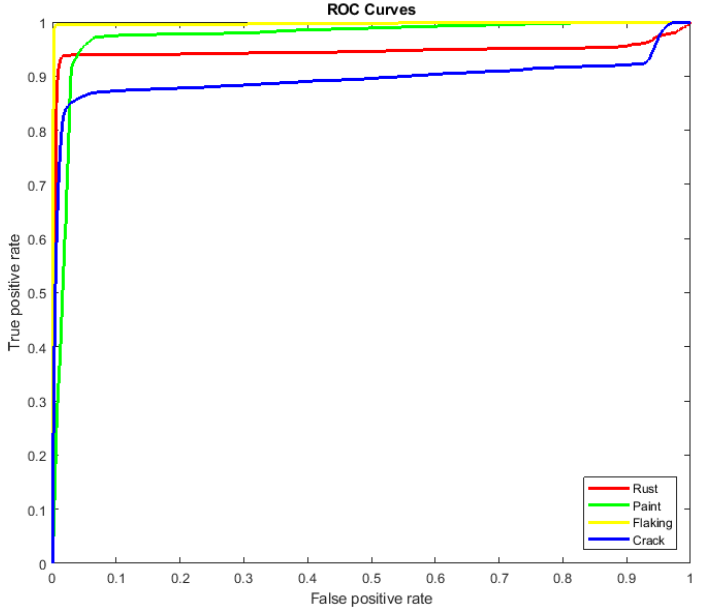
Figure 3. ROC curves generated for all classes: red for rust damage, green for paint, yellow for flaking, and blue for paint cracks.